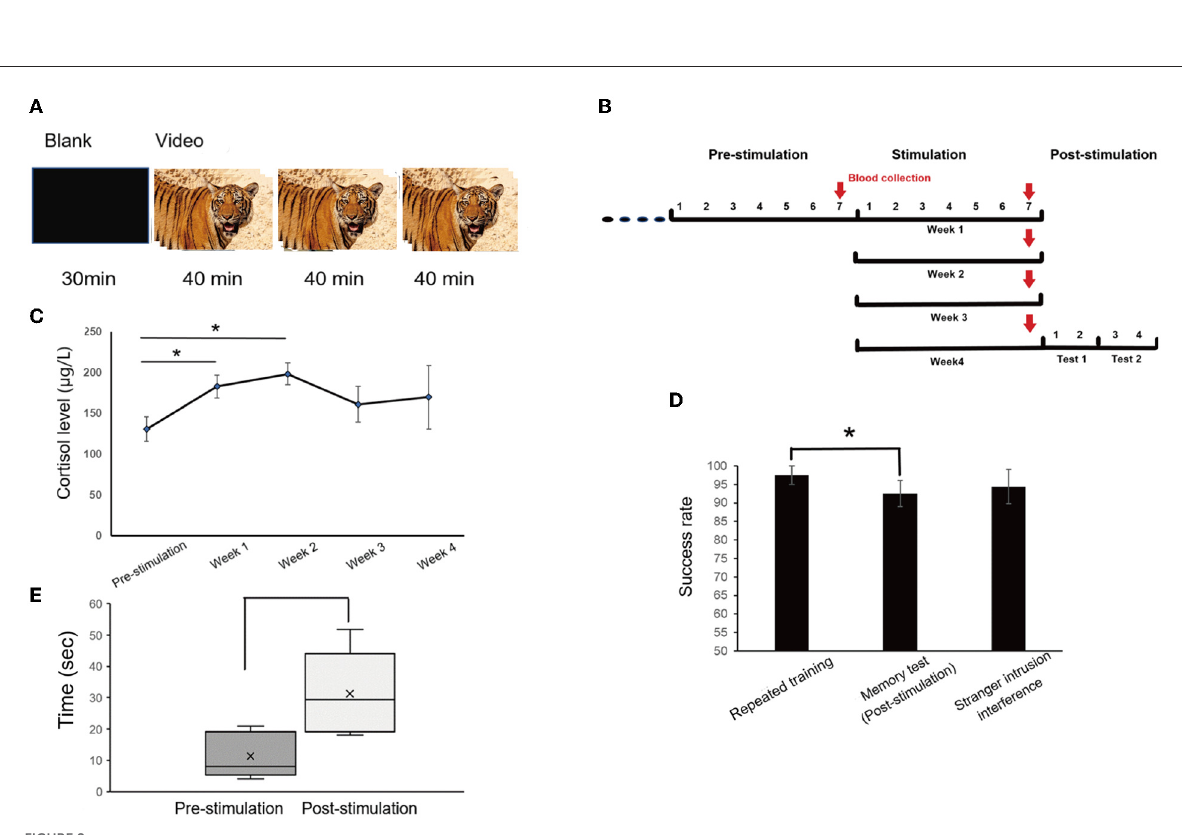
FIGURE8 Method of visual stimulation and the results after visual stimulation. (A) The daily session was for 2.5h per day, with blank images for 30min and the video for a total of 2h, including three trials, each for 40min. (B) Timeline of audio-visual stimulation and blood collection. Blood samples were taken once, the day before stimulation and every 6 days during stimulation, for a total of five times. (C) Cortisol analysis. Cortisol levels increased significantly at the end of the first and second weeks (one-way ANOVA, F 4,19 = 3.731, p = 0.027, followed by LSD post ho c test, * p < 0.05). (D) There was a significant difference between repeated training and memory tests after stimulation ( * p < 0.05). (E) The distraction time was significantly prolonged after audio-visual stimulation in the stranger intrusion interference test ( * p <